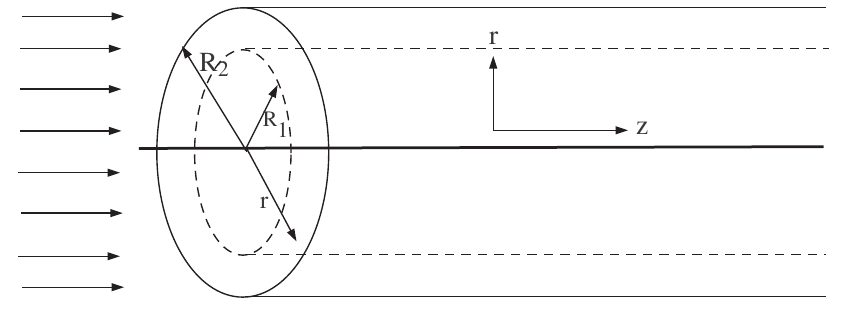
Figure 1. The geometry of the